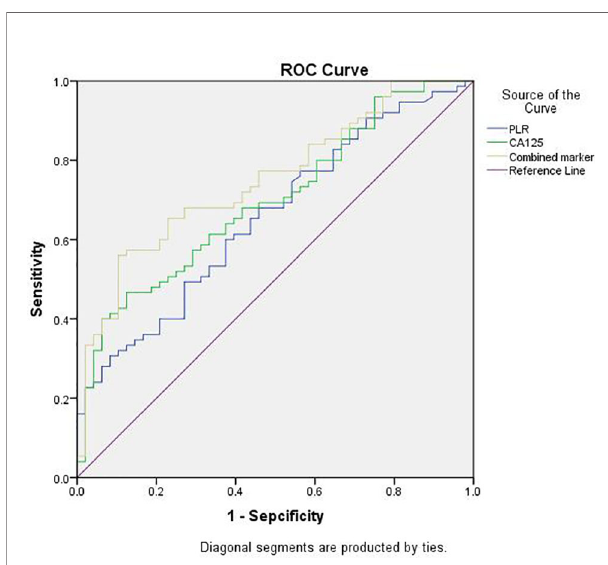
FIGURE 2 | ROC analysis of PLR, CA125 and combined marker for predicting severity of pelvic adhesions. PLR, platelet-to-lymphocyte ratio; Combined marker, the CA125 level multiplied by the PLR; ROC, receiver- operating